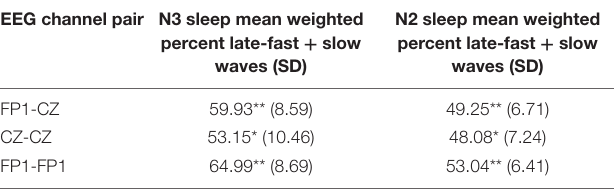
TABLE 3 | Stage N3- and N2-specific slow wave and spindle event counts and percentage of late-fast slow wave/spindle pairs from each channel pairing among the DREAMS subjects.